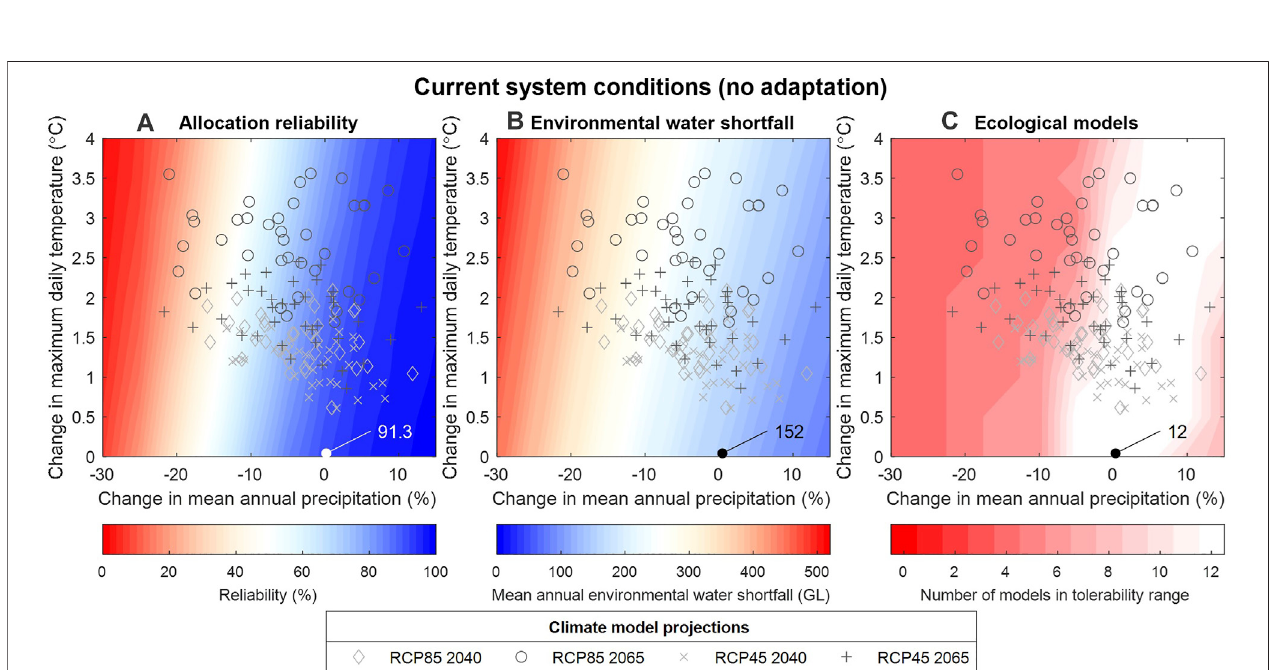
FIGURE 5 | Stress testing results for current system conditions (no adaptation) according to three output metrics: (A) allocation reliability; (B) environmental water shortfalls; and (C) ecological model responses. Note the x and y -axes are identical for all three plots. GCM outputs are plotted over failure surfaces for two time periods and two emissions scenarios. Also highlighted is the system performance in the absence of climate change (0, 0).